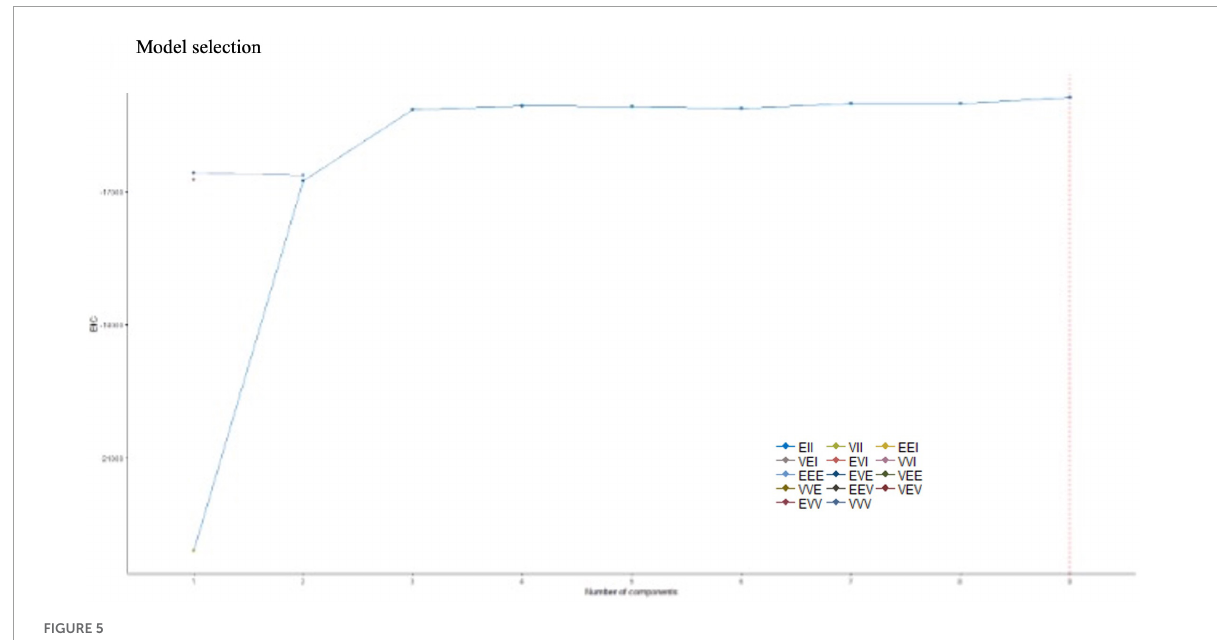
FIGURE5 Optimal Cluster. Selection of the optimal number of